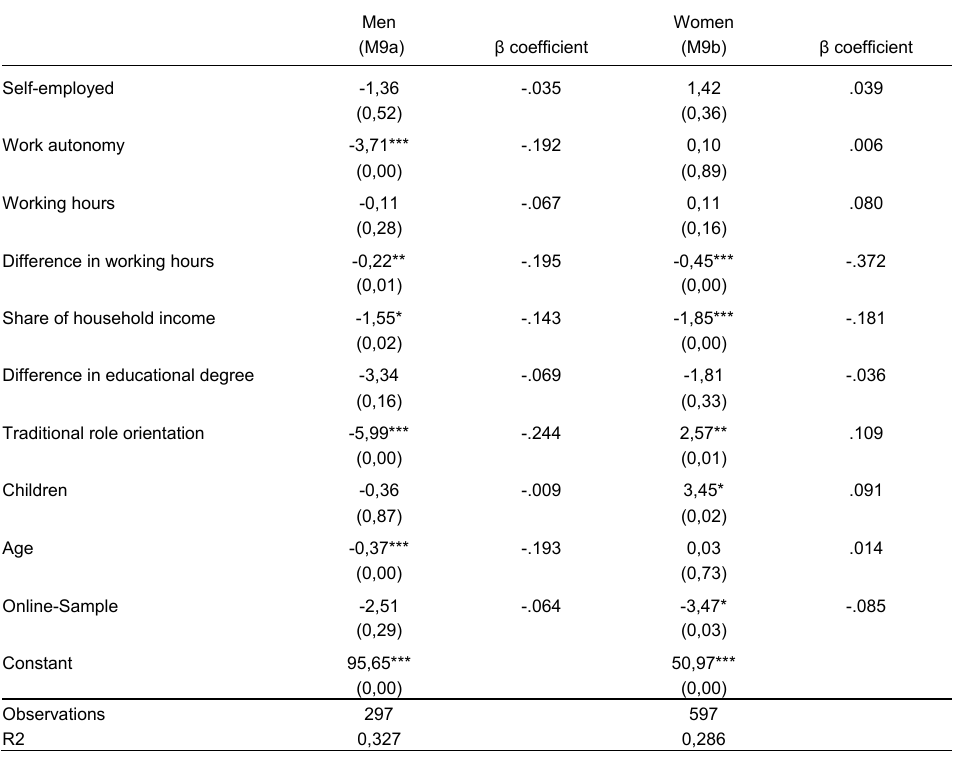
Table 4 : Linear regression on housework (Final model) Self-employed -1,36